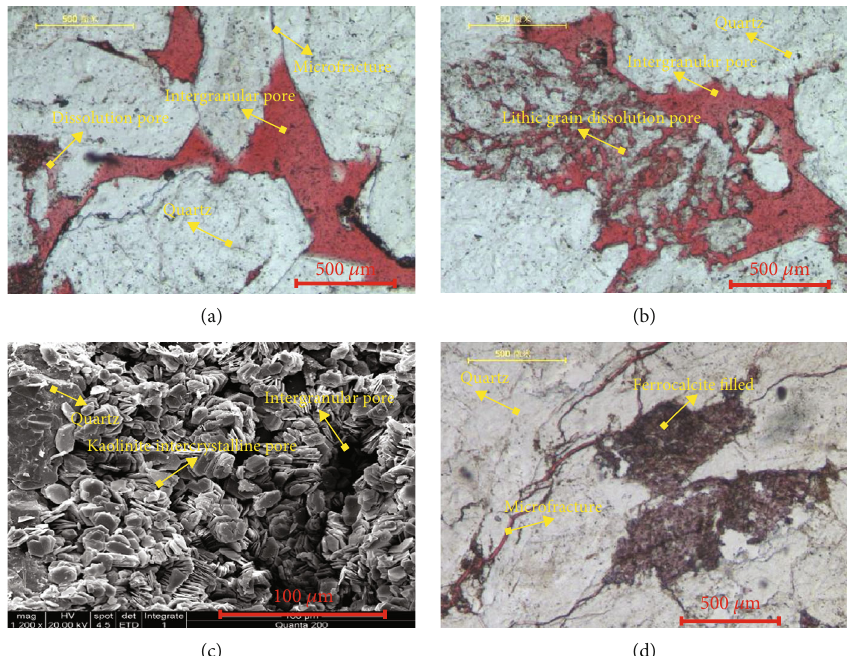
Figure 4: Micropore structure of the samples in the research area. (a) Well Y169, 2763.47m, CTS. (b) Well Y120, 2677.41m, CTS. (c) Well Y123, 2587.62m, SEM. (d) Well Y162, 2727.26m, CTS. Table 1: Mercury-injection data of the Shan-2 Member of the Shanxi Formation in the research area.